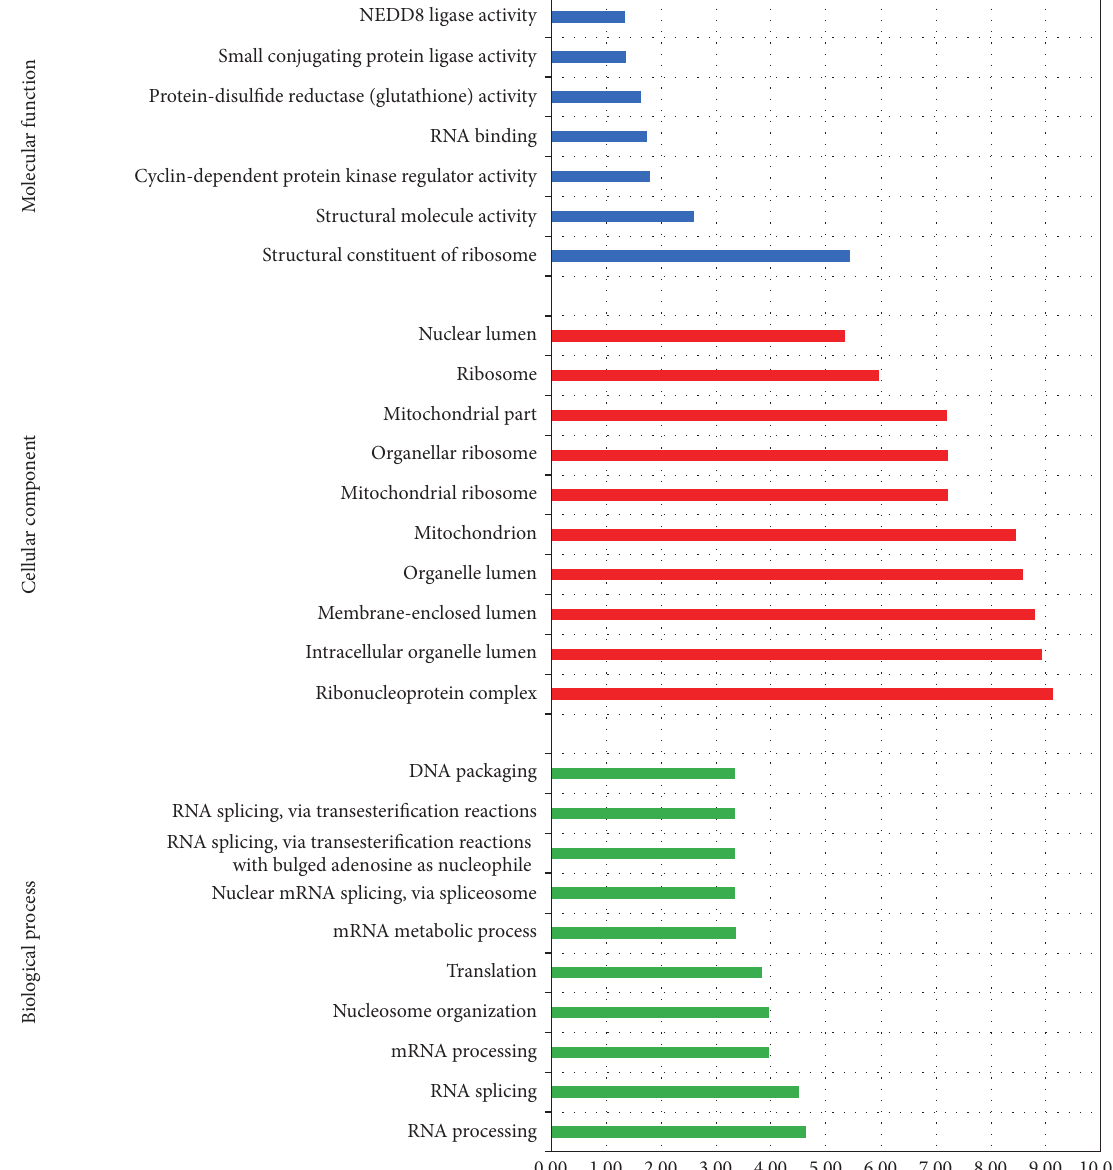
Figure 4: The 348 dysregulated proteins were analyzed according to gene ontology terms. All of the dysregulated proteins were analyzed by searching the DAVID database, 𝑃 < 0.05 . The histograms show the top 10 counts for molecular function, cellular component, and biological